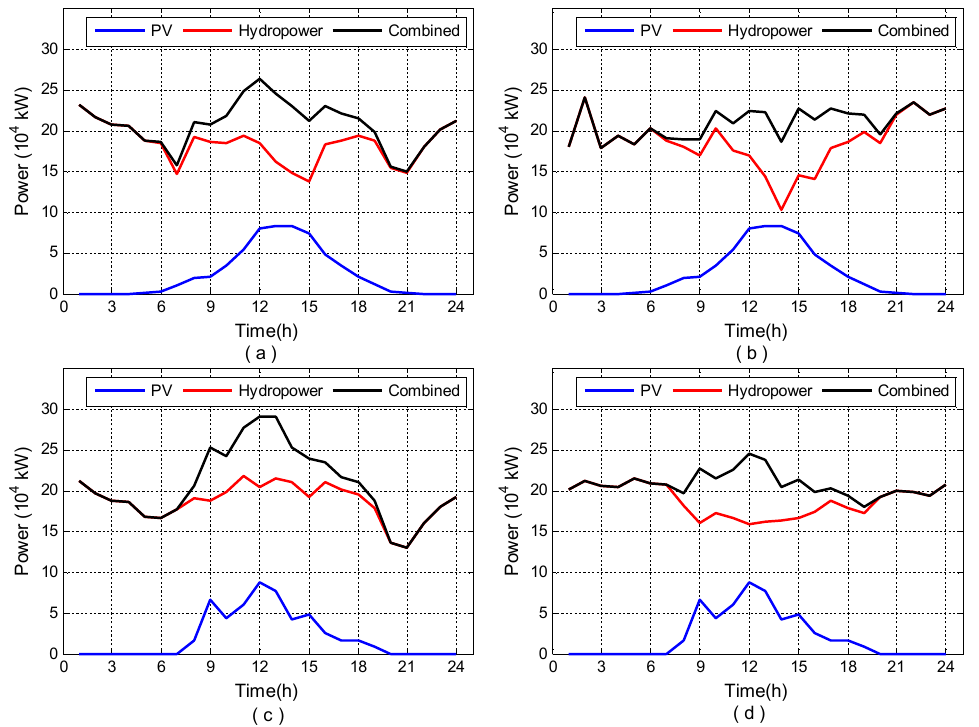
Figure 13. The output of the hydropower, photovoltaic, and joint system under a compromise solution. ( a ) Traditional solution for typical sunny day scenarios. ( b ) Hedging solution for typical sunny day scenarios. ( c ) Traditional solution for typical cloudy day scenarios. ( d ) Hedging solution for typical cloudy day